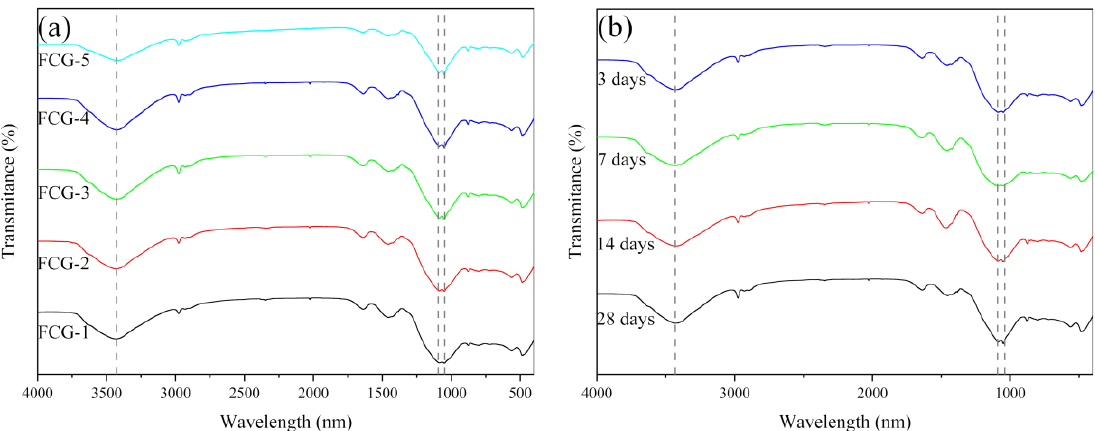
Figure 11. FTIR spectra of ( a ) bricks with different compositions in 28 days and ( b ) bricks with 5% FGD at different ages.